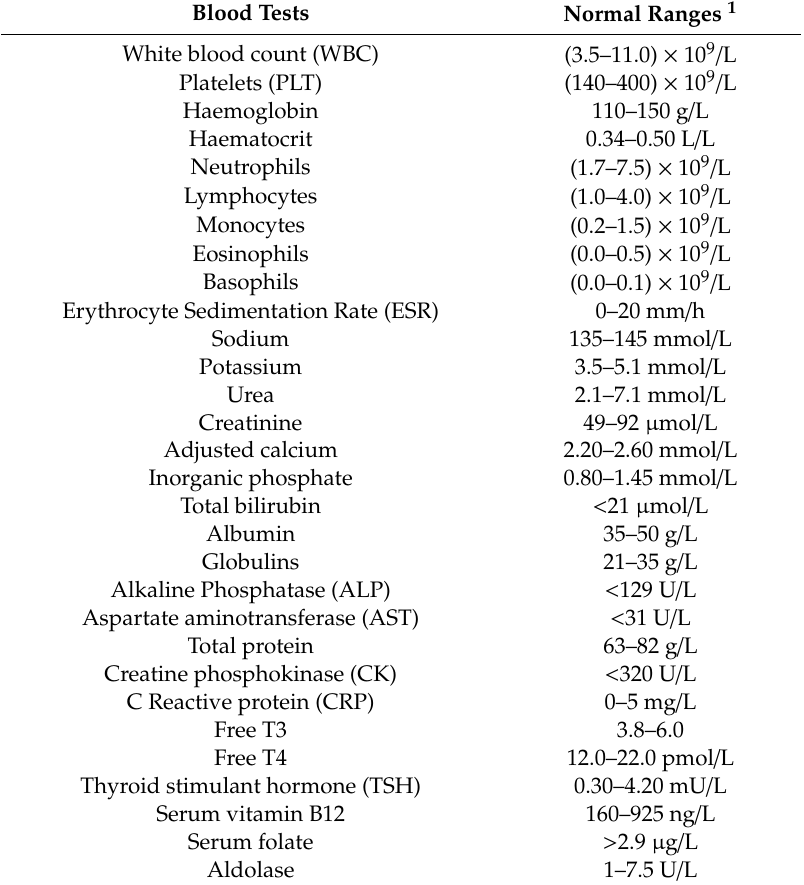
Table A1. Blood tests reference ranges used by NHS